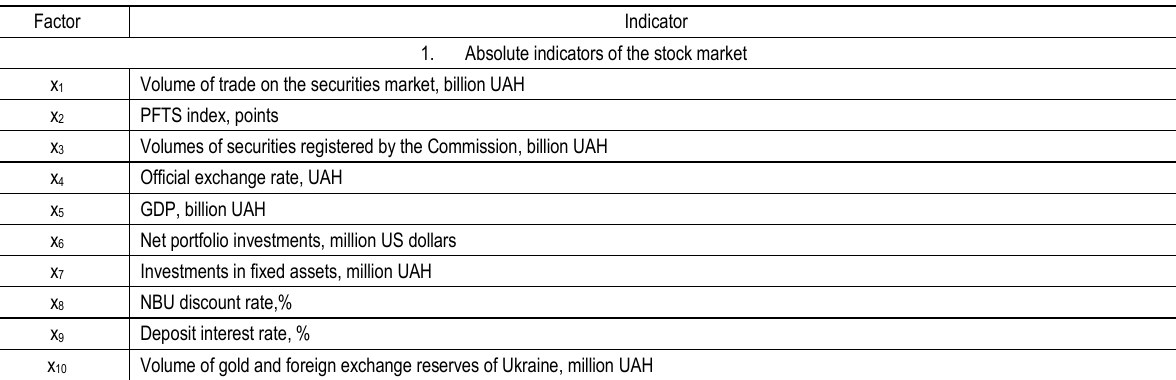
Table 1. Absolute indicators of the development of the stock and insurance markets, as well as the Ukrainian economy as a whole by